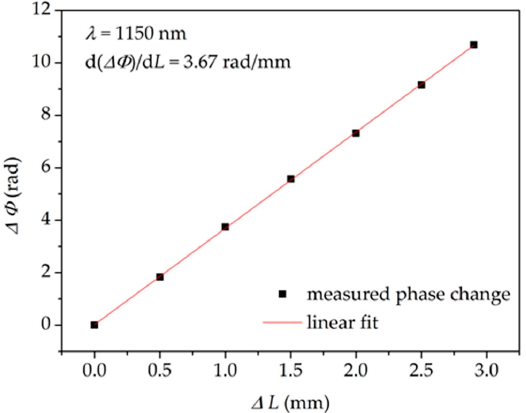
Figure 6. Differential phase shift increase Δ Φ of the interferometer induced by fiber elongation measured at λ = 1150 nm. ∆ L = change in length of interferometer.